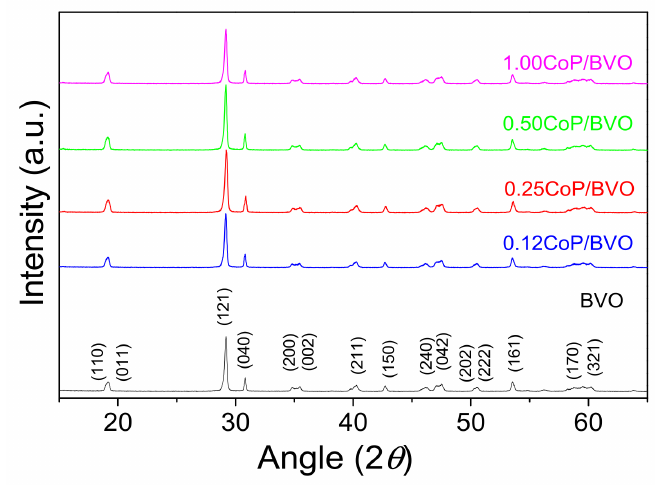
Figure 1. XRD patterns of pure BiVO 4 and CoP/BVO